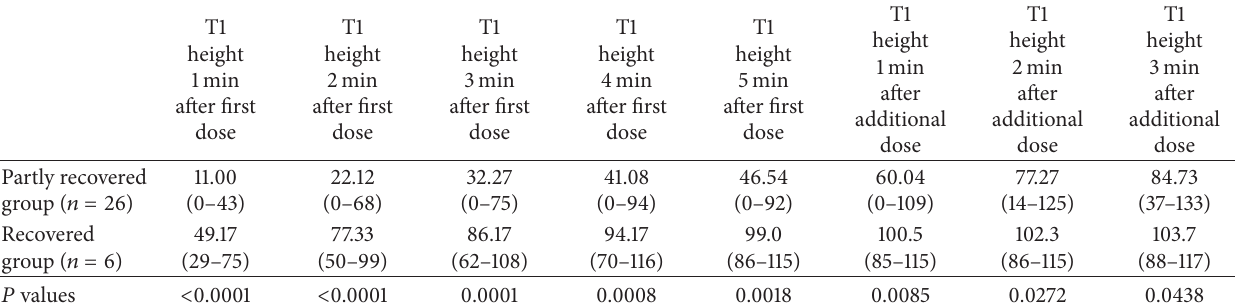
Table 3: T1 height at 1–5min after first dose and at 1–3 min after the additional dose of sugammadex.